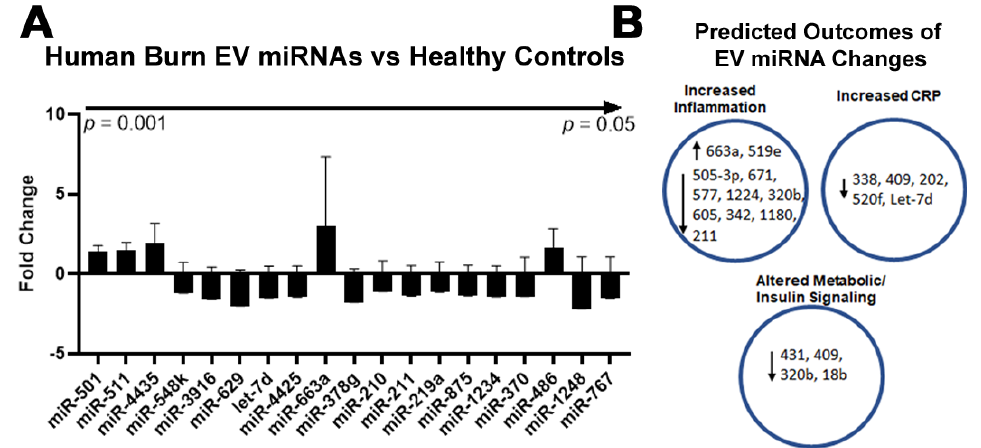
Figure 5. Proinflammatory miRNA signature in EVs from human burn patients by NanoString. Plasma EVs were isolated from human burn injury patients during the first 48 h of admission or healthy controls and miRNA content assessed by NanoString. ( A ) NanoString assessment of human burn patient EVs revealed that 26 miRNAs were significantly altered, 22 of which showed reduced expression. n = 3 per group. ( B ) Predicted outcomes of changes in differentially expressed miRNAs. Directional changes in 11 of the miRNAs would promote inflammation, while reductions in 5 miRNAs that target CRP would promote CRP expression, and reductions in 4 miRNAs that target metabolic and insulin signaling could alter cellular metabolism.